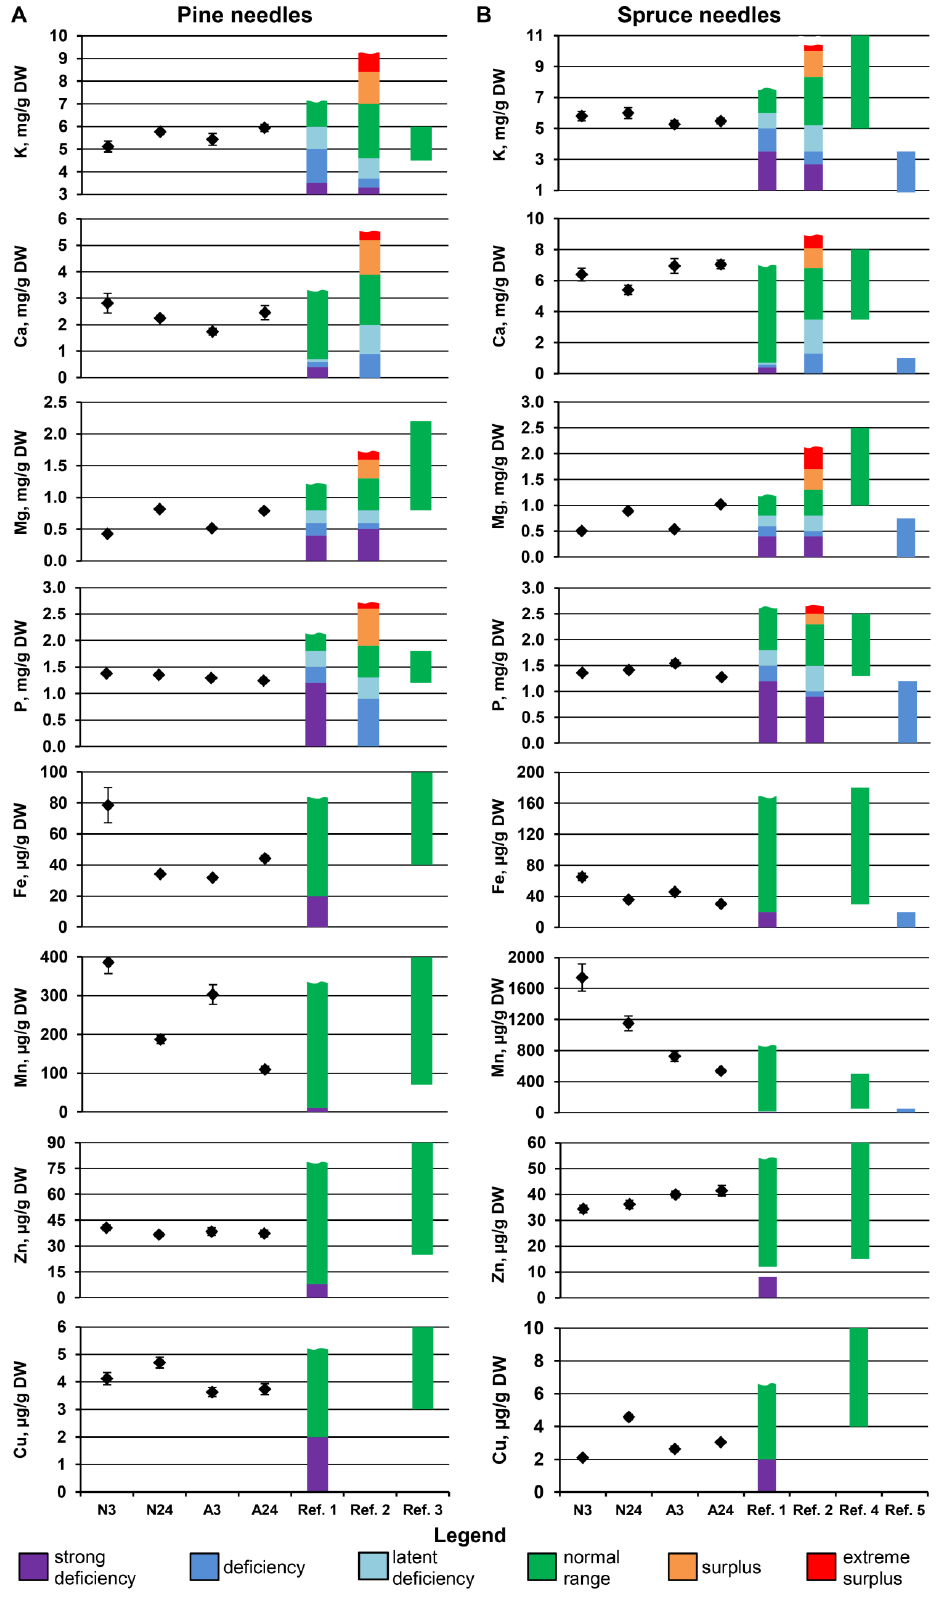
Figure 4. Comparison of the changes in element concentrations in pine ( A ) and spruce ( B ) needles with a known range of optimal nutrient concentrations. The mean values ± SEs are given (n = 8). Ref. 1—[27]; Ref. 2—[28]; Ref. 3—[29]; Ref. 4—[20], (for Fe—[30]); Ref.